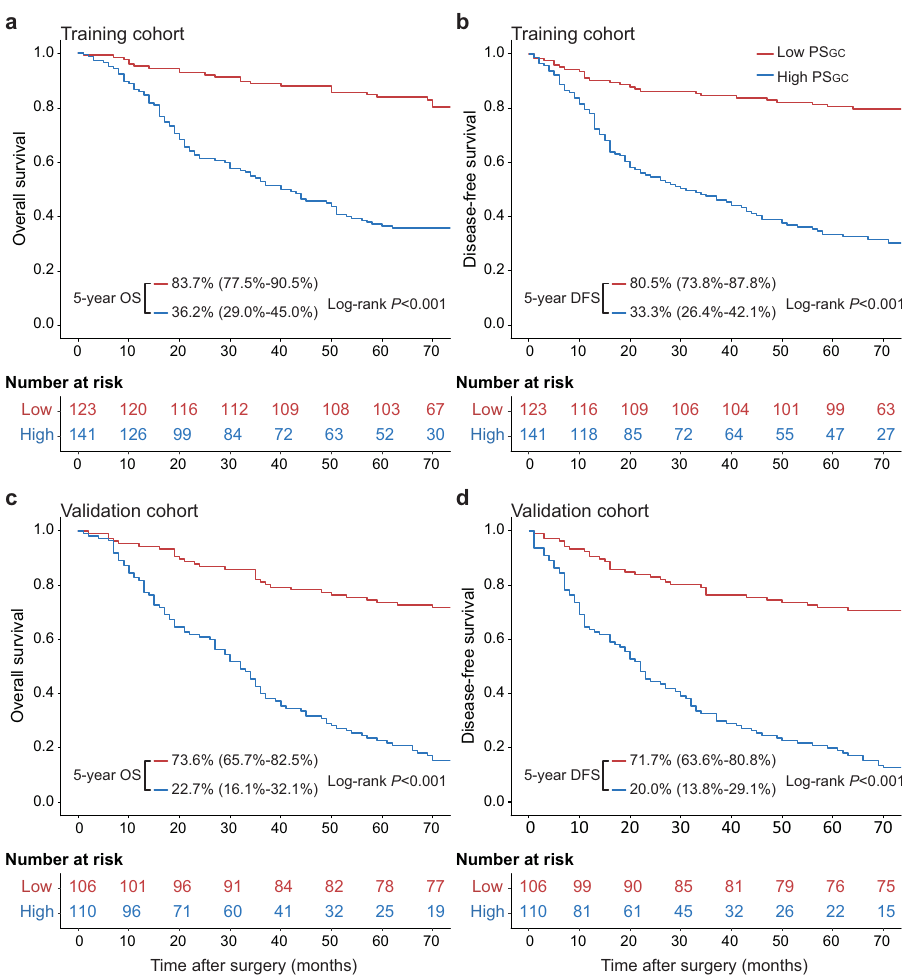
Fig. 2 | Kaplan – Meier survival curves according to the PS GC level. a The OS rate difference between the high- and low-PS GC patients in the training cohort. b The DFSratedifferencebetweenthehigh-and low-PS GC patientsinthe trainingcohort. c The OS rate difference between the high- and low-PS GC patients in the validation cohort. d The DFS rate difference between the high- and low-PS GC patients in the